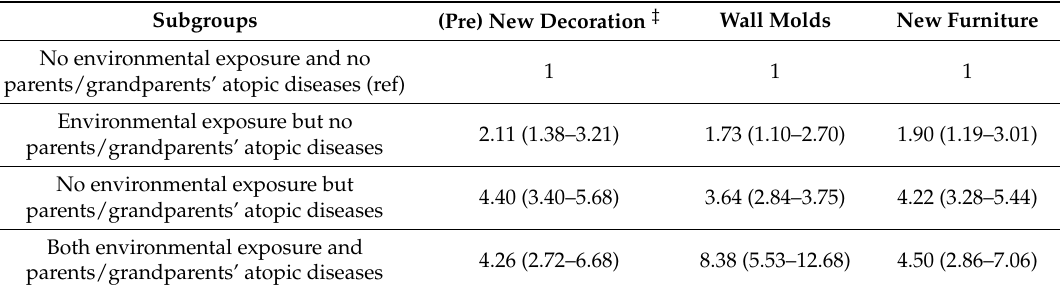
Table 3. The individual and combined effects (AOR, 95%CI) of home risk factors and parents/grandparents’ atopic diseases on childhood AD †